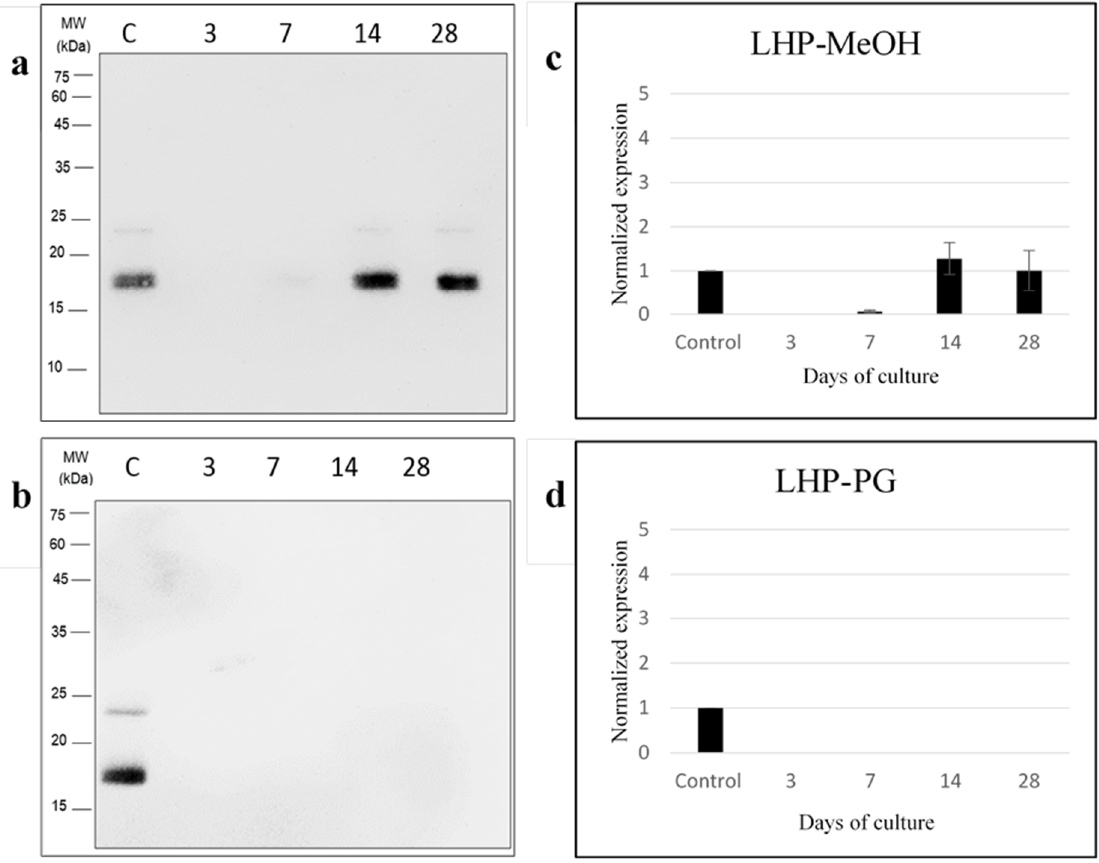
Figure 4. Western blot for Breviolum LHP expression for the ( a ) MeOH and ( b ) PG treatment groups after days of culture. The horizontal axis shows C as the control group (fresh Breviolum without freezing), and 3, 7, 14 and 28, as days of culture after thawing Breviolum LHP expression for the ( c ) MeOH and ( d ) PG treatment groups after same days of culture. The error bars represent standard deviation, and each group was repeated 3 times.